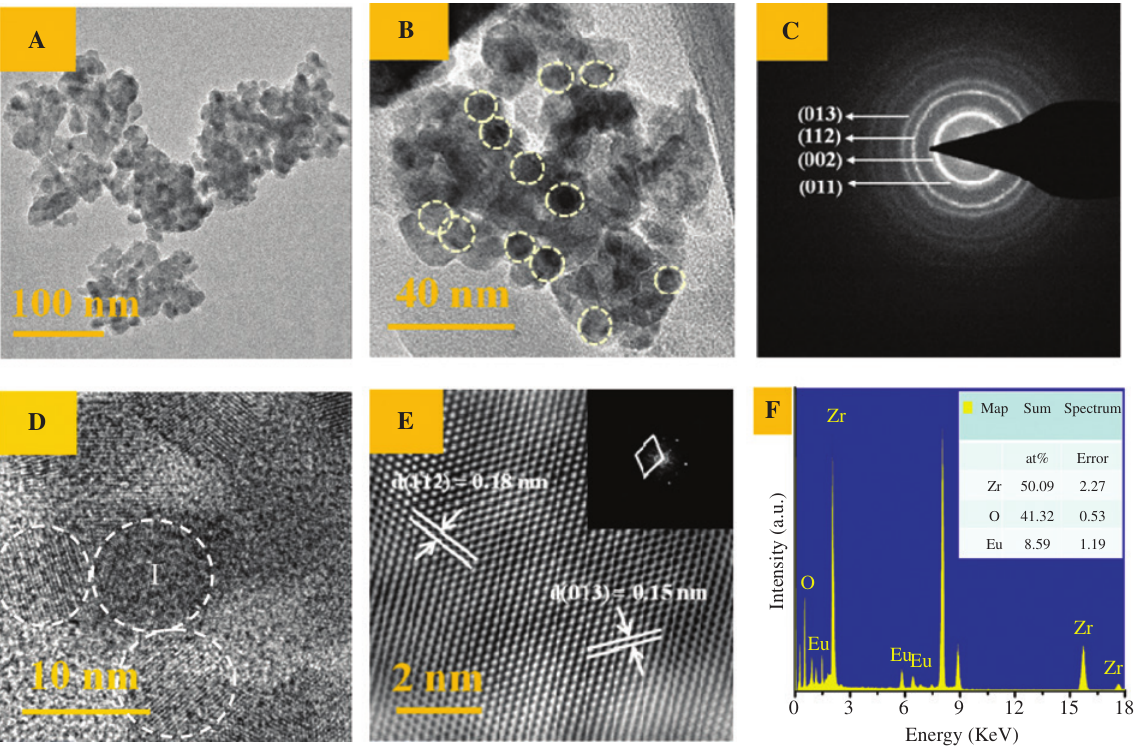
:Eu 3 + nanocrystals. Figure 3: The morphology observation of ZrO 2 (A, B) TEM images of ZrO :10%Eu 3 + nanocrystals. (C) SAED pattern. (D) HRTEM image. (E) Fourier-filtered HRTEM image of the region I in (D). 2 The inset is the Fourier-transformed image. (F) EDS spectrum.